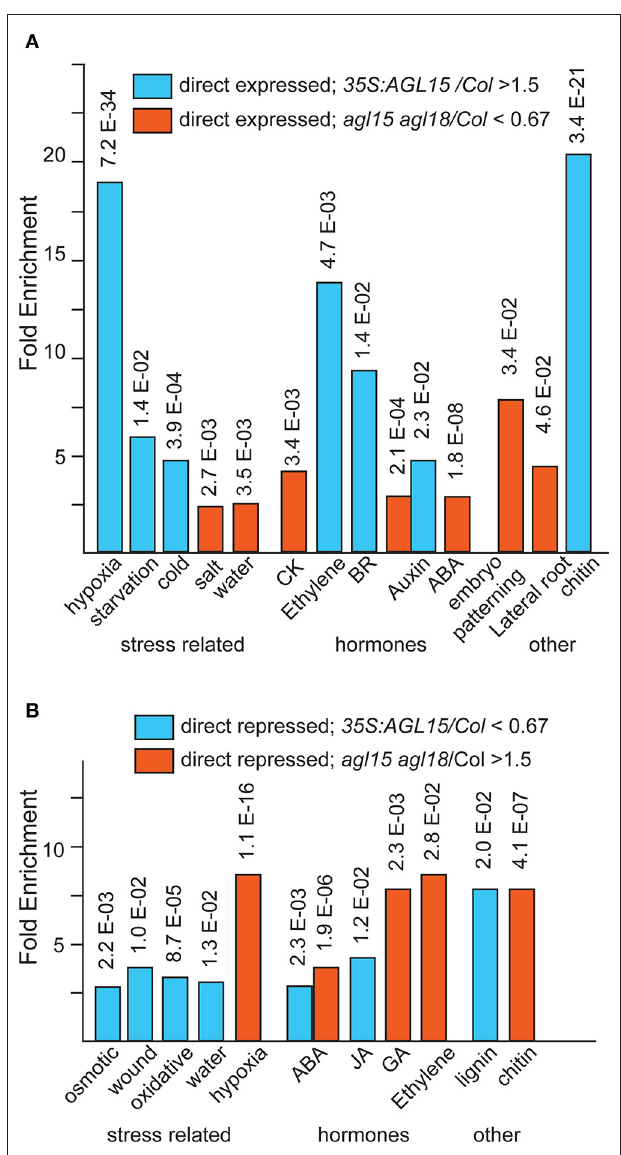
FIGURE 5 | Overrepresented GO annotations among the direct (as measured in ChIP-chip and/or ChIP-seq) and responsive (at least a 1.5-fold change at P < 0.05). Data is from the Panther Classification system accessed July 9, 2021. (A) Directly expressed. (B) Directly